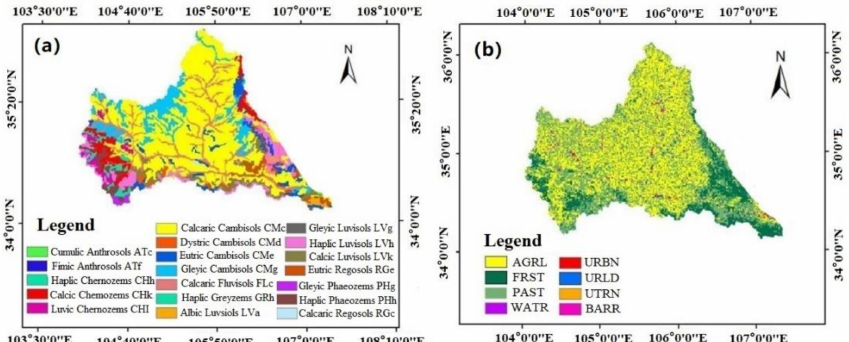
Figure 2. Distribution of soil types ( a ) and land cover types ( b